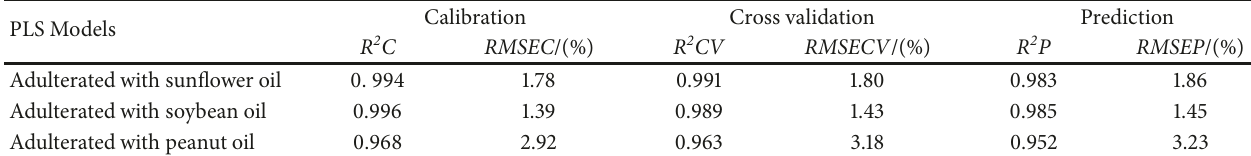
Table 2: Requisite parameters for adulteration level prediction in adulterant canola oil